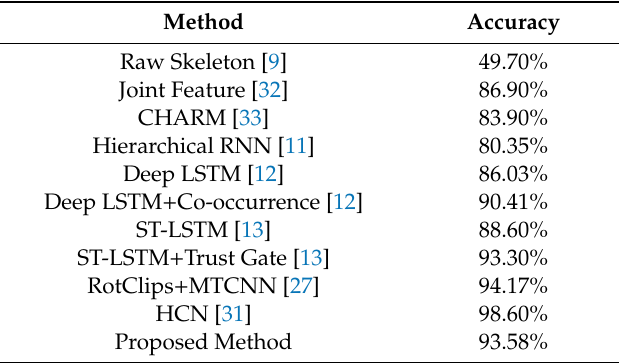
Table 2. Performance comparison of di ff erent methods on SBU